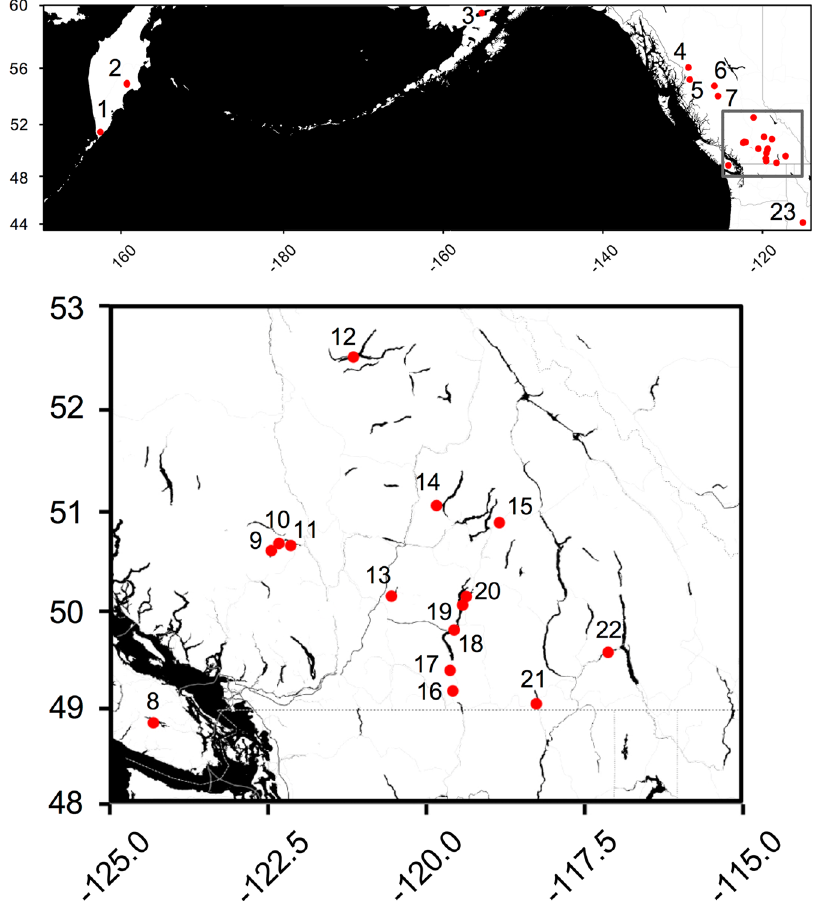
Figure 1. Map of sampling localities included in this study across the range of Oncorhynchus nerka . Locality numbers as in Table 1. The map was generated in R 67 using the ggmap package 68 with map tiles by Stamen Design (www.stamen.com), under CC BY 3.0 (creativecommons.org/licenses/by/3.0/) and data by OpenStreetMap (www.openstreetmap.org/), under ODbL